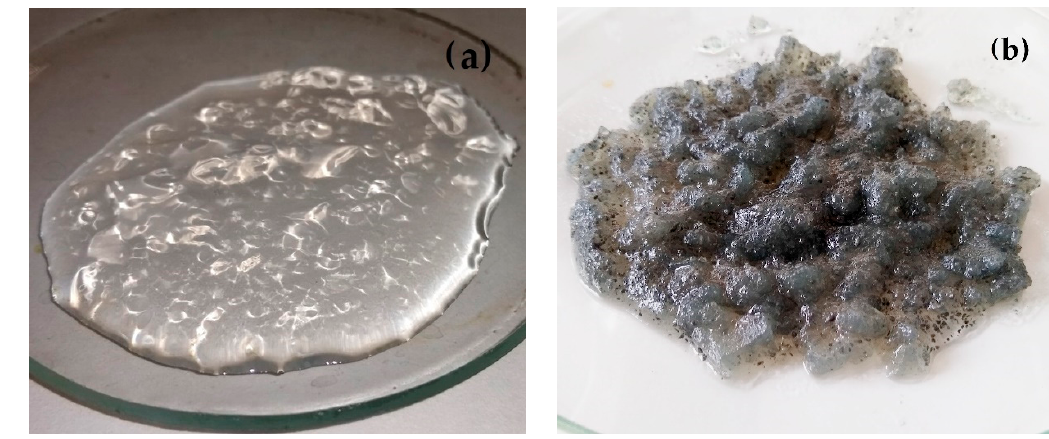
Figure 13. Gel aggregates present in the solutions after direct leaching of the Li slag: ( a ) formed after filtration of the leaching residue; ( b ) formed before filtration with entrapped leaching residues particles.